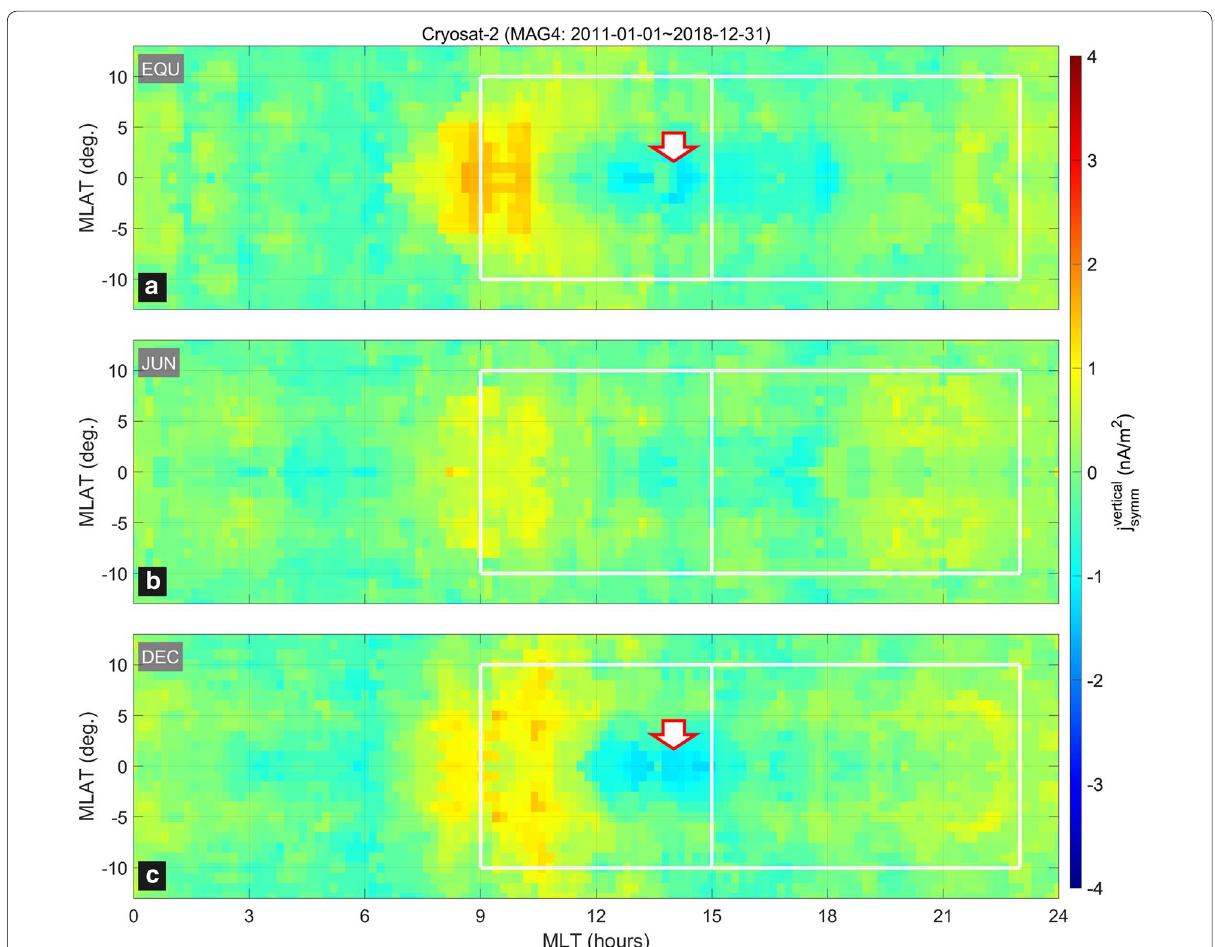
Fig. 4 Similar to Fig. 2, but hemispherically symmetric components (i.e., F-region dynamo currents) of vertical current density from